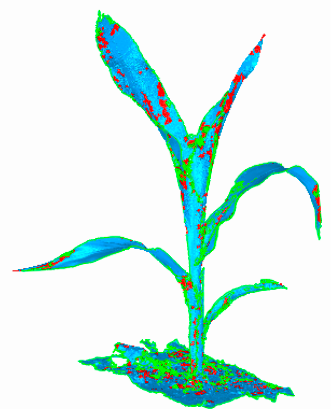
Figure 3. Characteristic region classification of three-dimensional (3D) point clouds of maize. Red points indicate the single region, other points represent rich region and are needed to be denoised by bilateral filtering